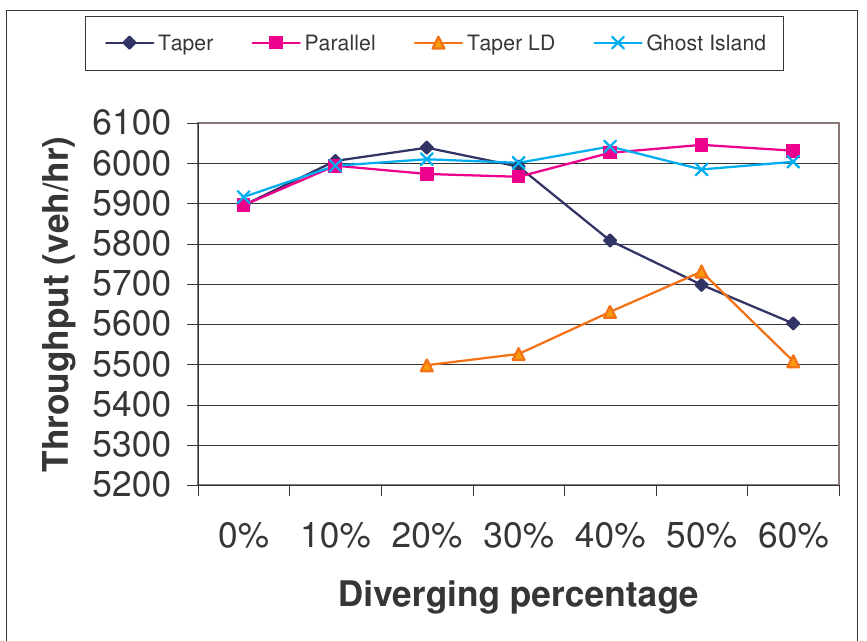
Figure 7. Throughput results for the four layouts with 15%